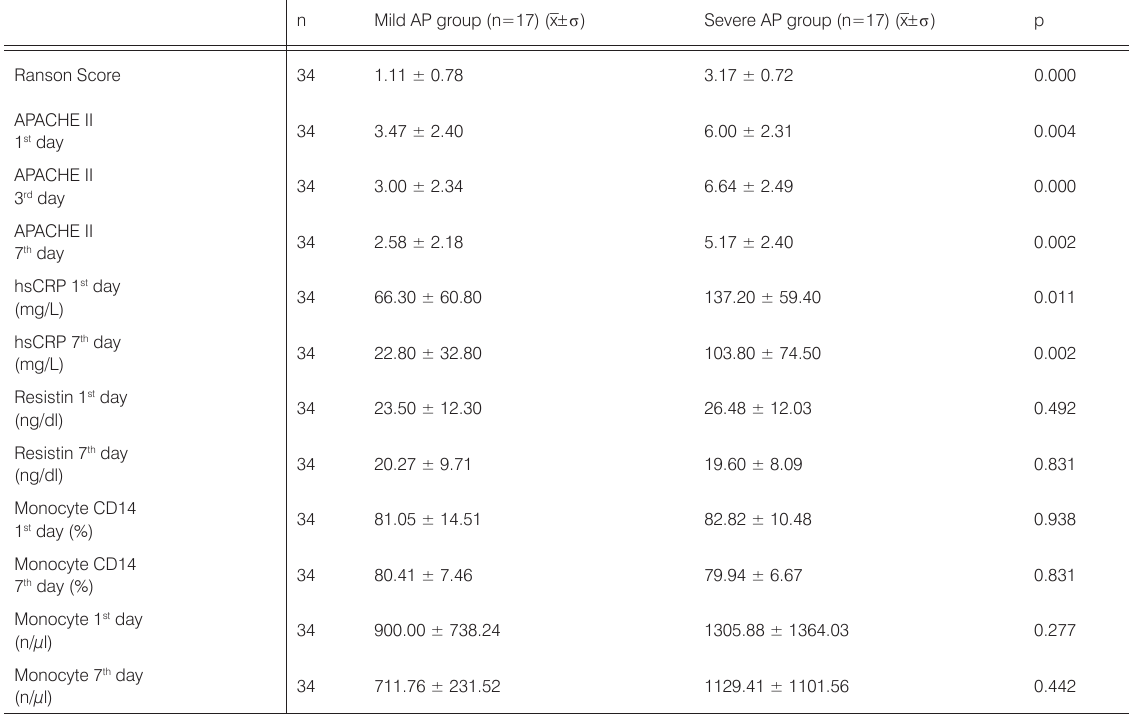
Table 2. The mean serum levels of hsCRP, Resistin, monocyte, and monocyte CD14 and Ranson and APACHE II scores of the mild and severe AP groups n Mild AP group (n=17) (– x ± σ